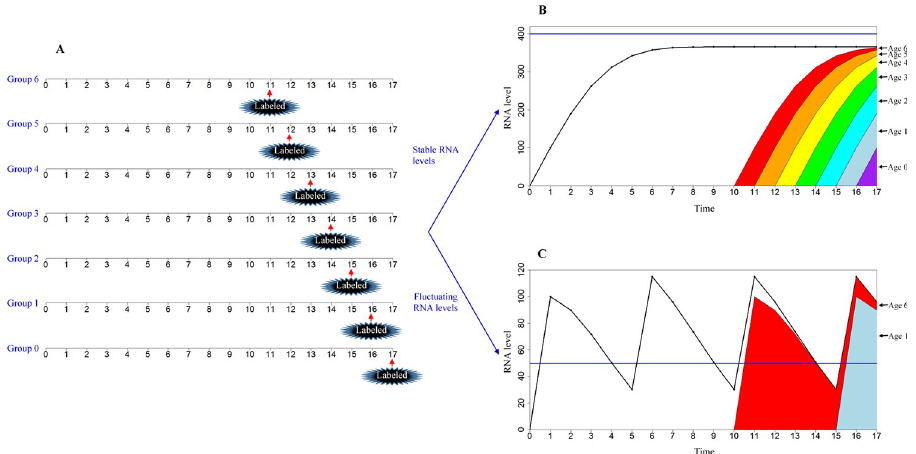
Fig 6. Measurement of RNA age distribution based on the present model. (A) Design of the experiment. Seven groups of the cells were used in the experiments. The cells were cultured in unlabelled normal media at time 0 and exposed to labelled media at time 11 in Group 6, at time 12 in Group 5, at time 13 in Group 4, at time 14 in Group 3, at time 15 in Group 2, at time 16 in Group 1, and at time 17 in Group 0. The samples were collected from time 0 to time 17, and RNA levels (of one gene or some genes) were detected. At the time of exposure in labelled media and later, unlabelled RNAs and labelled RNAs were separated and detected. The RNA level at a certain RNA age at a certain time point was calculated based on the differences between labelled RNA levels in two adjacent groups. Consider RNA levels at time 17 an example. RNA level at age 6 = labelled RNA level in Group 6 –labelled RNA level in Group 5, RNA level at age 5 = labelled RNA level in Group 5 –labelled RNA level in Group 4, RNA level at age 4 = labelled RNA level in Group 4 –labelled RNA level in Group 3, RNA level at age 3 = labelled RNA level in Group 3 –labelled RNA level in Group 2, RNA level at age 2 = labelled RNA level in Group 2 –labelled RNA level in Group 1, RNA level at age 1 = labelled RNA level in Group 1 –labelled RNA level in Group 0, and RNA level of age 0 is labelled RNA level in Group 0. (B) RNA age distribution under stable RNA levels. Blue line represents the demand for RNA activity (DRA). Black curve represents the total amount of RNA (TR). Colours indicate levels of RNAs labelled at various time points, and levels of RNAs labelled at later times cover the levels of RNA labelled at earlier times. The RNA levels at age 6, age 5, age 4, age 3, age 2, Age 1, and age 0 were 6 (= 364–358), 15 (= 358–343), 31 (= 343–312), 50 (= 312–262), 72 (262– 190), 90 (190–100), and 100, respectively (DRA is 400. If total RNA activity (TRA) < DRA, then RNA level at age 0 = 100; otherwise, RNA level at age 0 = 0. The survival rate decreases at older RNA ages, i.e., the type B RNA survival rate is shown in S2 Table. The RNA activity coefficient of each RNA age is 1, i.e., the type A RNA activity coefficient in S2 Table). The x-axis is time, and the unit of time is RNA age, which is standardized as unitless values. The y-axis is the RNA level, which is standardized as unitless values. (C) RNA age distribution under conditions of fluctuating RNA levels. The blue line represents DRA. Black curve represents TR. Colours indicate the levels of RNAs labelled at various time points, and levels of RNA labelled at later times cover the levels of RNA labelled at earlier times. The RNA levels at age 6, age 5, age 4, age 3, age 2, age 1, and age 0 were 6 (= 96–90), 0 (= 90–90), 0 (= 90–90), 0 (= 90–90), 0 (= 90–90), 90 (90–0), and 0, respectively (DRA is set to 50. If TRA < DRA, then RNA level at age 0 = 100; otherwise, RNA level at age 0 = 0. The survival rate decreases at older RNA ages, i.e., the type B RNA survival rate is shown in S2 Table. The RNA activity coefficient of each RNA age is 1, i.e., the type A RNA activity coefficient in S2 Table). The x-axis is time, and the unit of time is RNA age, which is standardized as unitless values. The y-axis is the RNA level, which is standardized as unitless